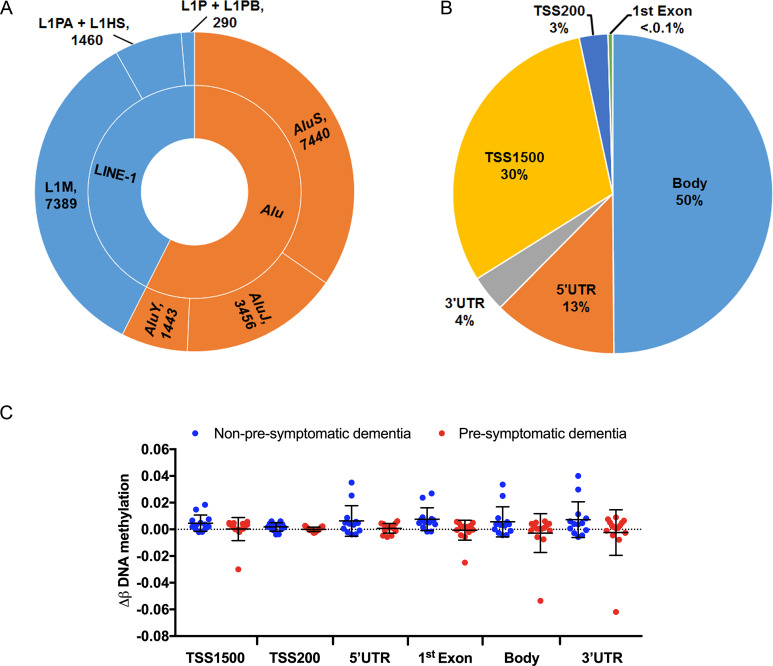
Distribution and methylation changes of LINE-1 and Alu probes.(A) Number of total probes by evolutionary age of LINE-1 and Alu elements. (B) Number of probes by genomic location. (C) Alterations in DNA methylation of retrotransposons at the 18-month follow-up in non-pre-symptomatic dementia and pre-symptomatic dementia by genomic location.